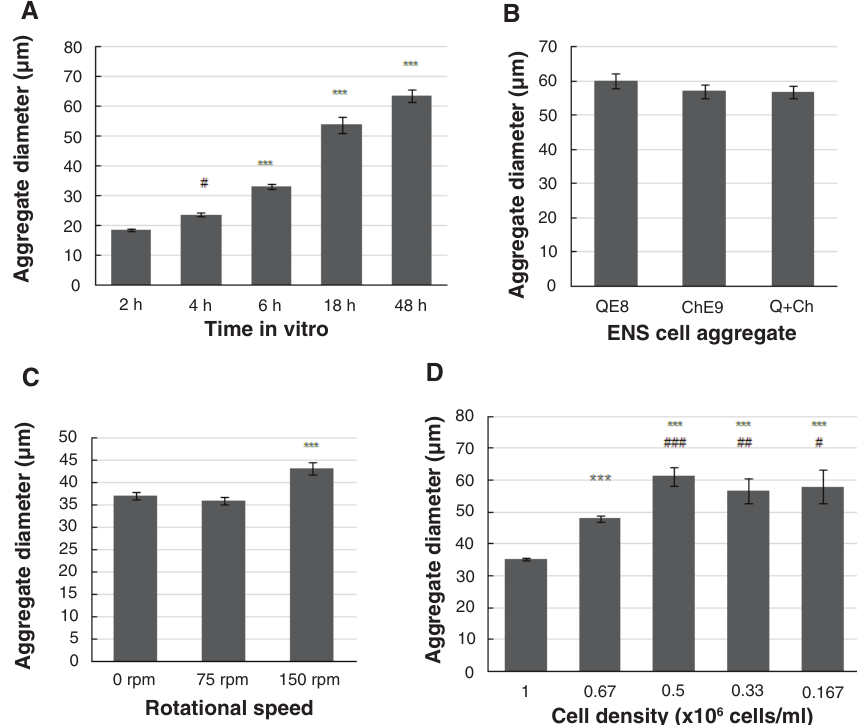
Figure 5. Histograms of the size of ENS cell aggregates in rotation cell-cell adhesion assays. A . QE8 cell aggregates gradually increased in diameter from 0–48 h in vitro . (# p=0.0229, 4h vs 2h; ***p<0.001 for all other times). Starting cell density 0.3×10 6 cells/ml. B . ENS cells from QE8, ChE9 and mixed populations (Q+Ch) showed identical aggregation at 18 h in vitro , with no significant difference (Q: Ch p=0.29; Q:Q+Ch p=0.23; Ch:Q+Ch p=0.93;). Starting cell density 0.3×0 6 cells/ml. C . Aggregate diameter attained at 18 h in vitro was slightly larger at the highest rotational speed (*** p<0.001, 150 rpm vs 0 and 75 rpm). Starting cell density 0.5×0 6 cells/ml. D . Aggregate diameter at 18 h in vitro was starting cell density-related. Starting cell density at 1×10 6 cells/ml produced aggregates of least diameter. With the gradually reduced starting cell density, the aggregate diameter increased (relative to 1×10 6 cells/ml: *** p<0.001; relative to 0.67×10 6 cells/ml: # p=0.0186, ### p<0.001). However, this increase plateaued, with no significant difference in aggregate diameter at 0.167, 0.33 and 0.5×10 6 cells/ml. Error bar=SEM.